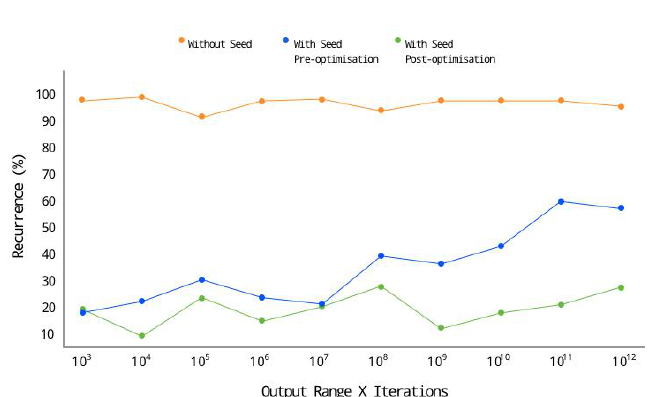
Fig. 24. Performance of three models low noise scenario II